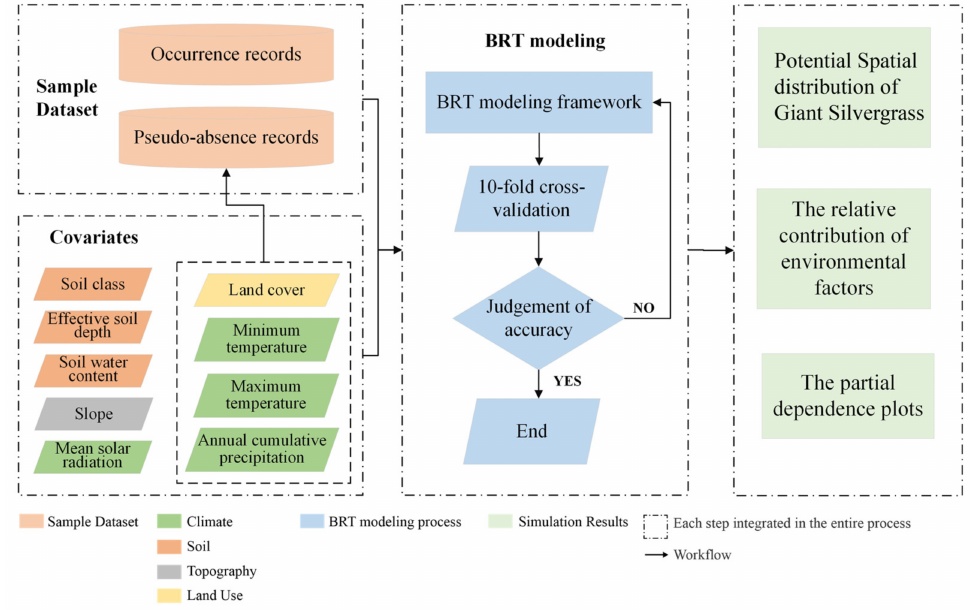
Figure 1. The technical flow chart of this study.